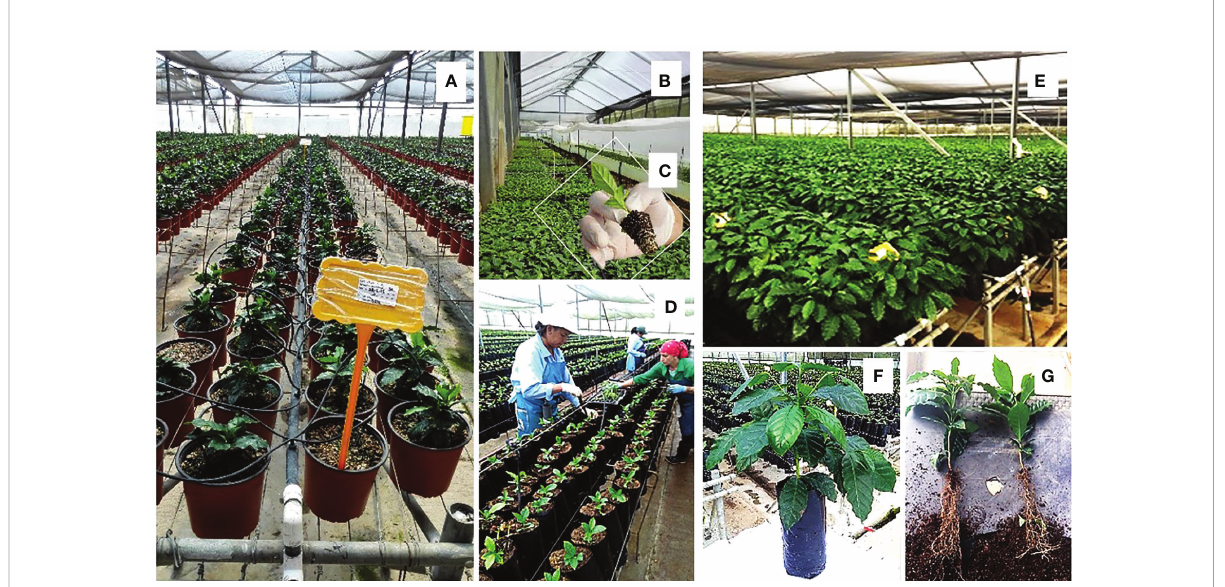
FIGURE 8 Industrial multiplication of coffee F1 hybrids. (A) Cutting producer mother plants at the Paraiso-Gaia Artisan Coffee farm (Costa Rica); (B) plastic tunnels for rooting cuttings; (C) rooted cutting; (D) planting of rooted cuttings in bags; (E) plants developed over 5 months at Gaia Artisan Coffee; (F) aerial development of plants in bags; (G) development of the root system in 5-month old